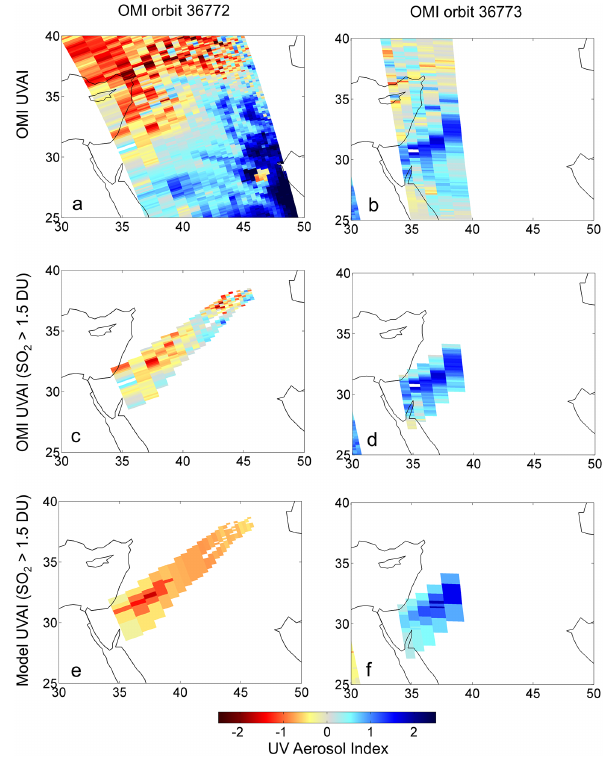
Figure 3. UV Aerosol Index from OMI (panels a–d ) and from RTM calculations ( e–f ) for the volcanic plume detected on 14 June 2011. The left panels ( a , c , and e ) show data from orbit 36772; on the right (panels b , d , and f ) data from the following orbit, 36773, are shown. The data in panels c–f are filtered by SO 2 vertical column density ( ≥ 1 . 5DU) to more clearly show the volcanic plume. The UVAI in panels (e) and (f) were modelled using McArtim with aerosol parameters representative of sulfate particles at 18–19km altitude (see text for